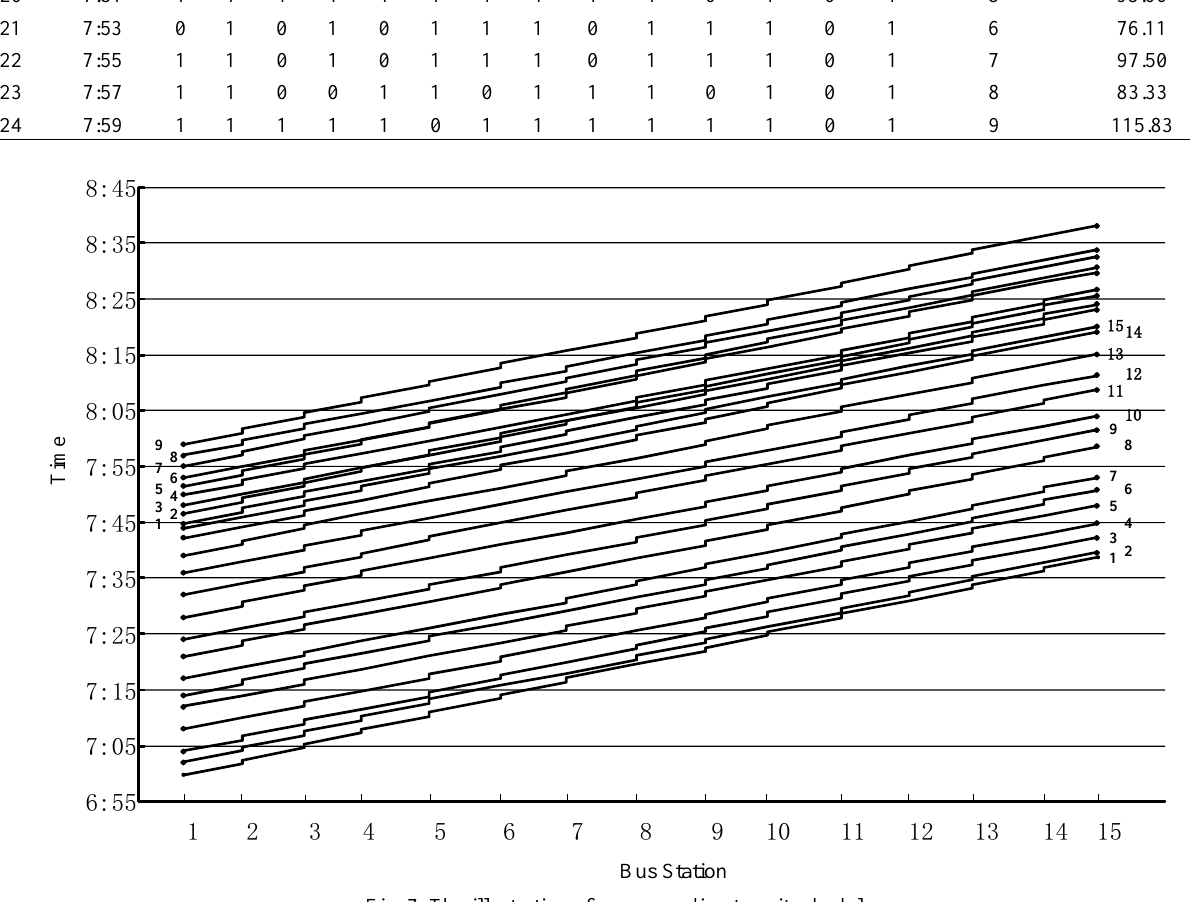
Fig. 7. The illustration of corresponding transit